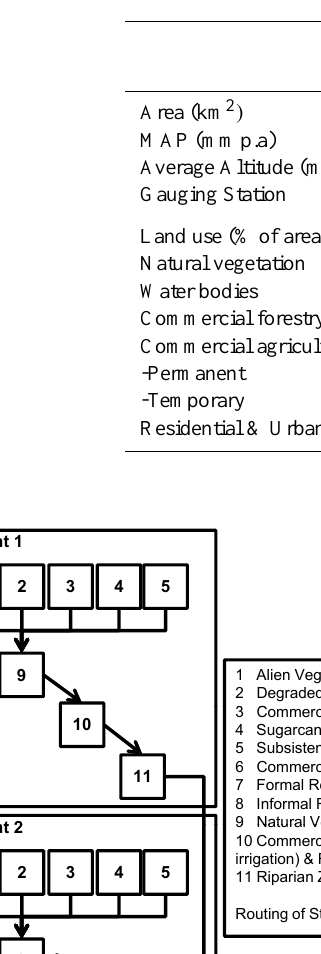
Table 4. Summary of selected features and land uses of the Upper Breede Catchment and the WMUs selected for verification.